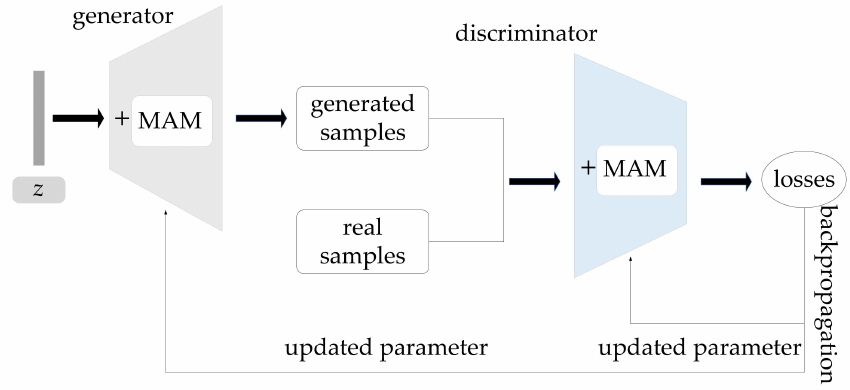
Figure 2. Network structure of the proposed